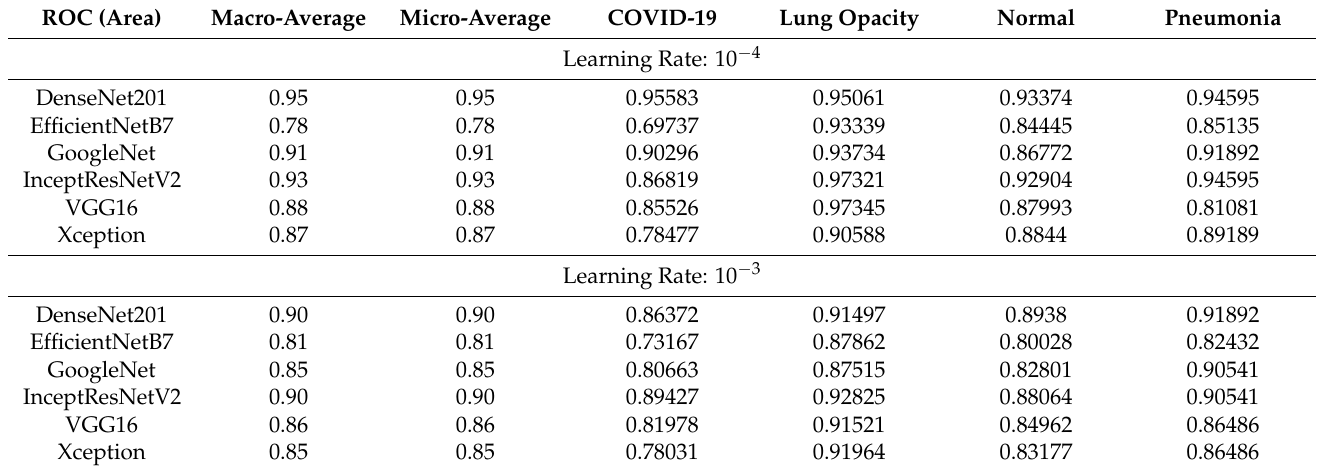
Table 5. ROC and precision-recall curve of the backbone model using Data_A.